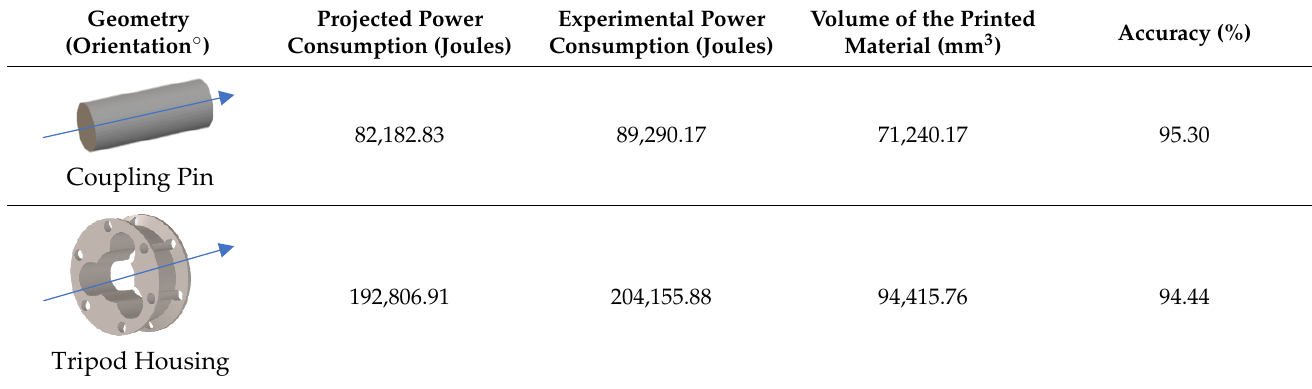
Table 4. Accuracy verification of the joint predictive model for two different parts .